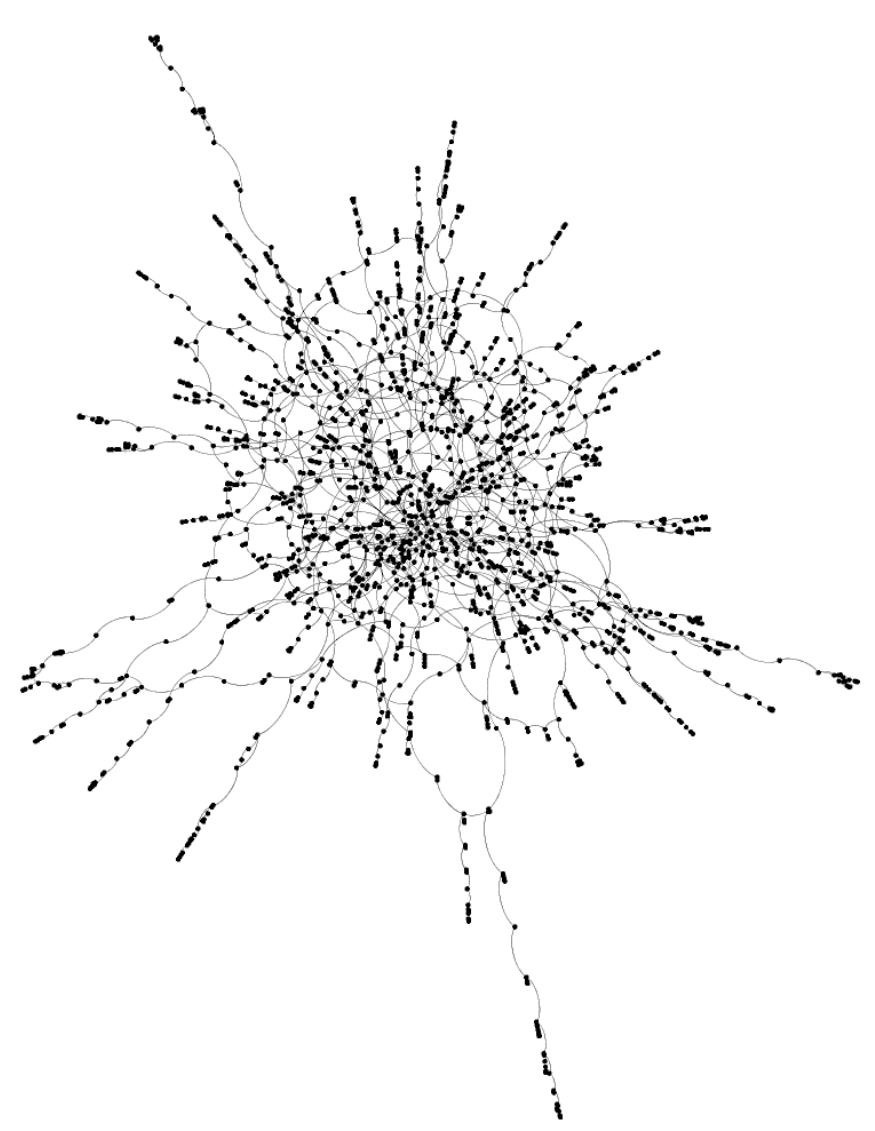
Figure 3. The giant component of the phonological network with 90% of the connections removed.